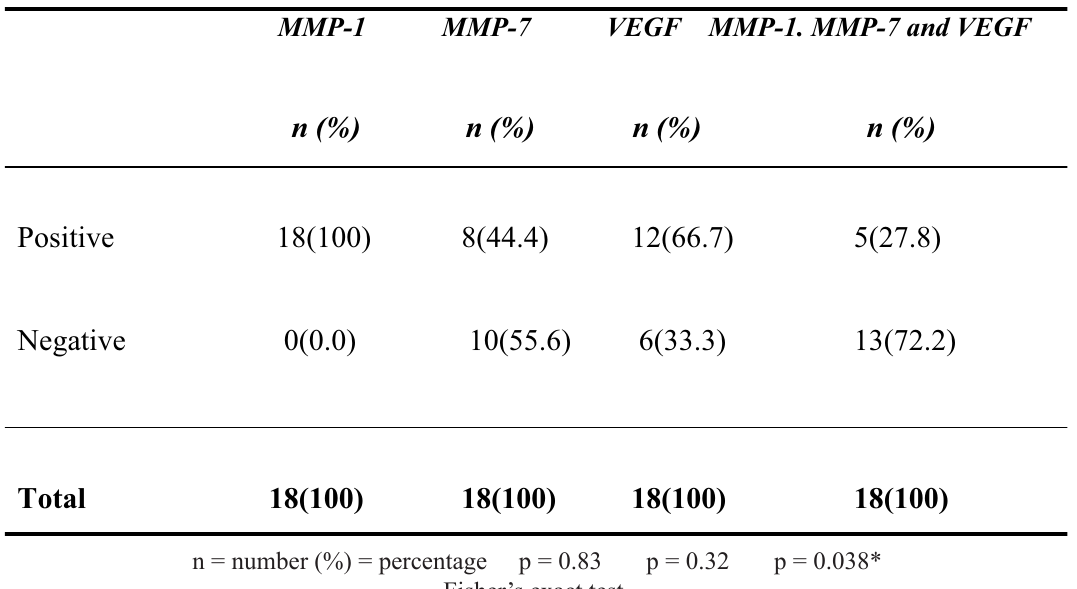
TABLE 2 – Distribution of separate and grouped expressions of MMP-1, MMP-7 and VEGF in relation to tumor